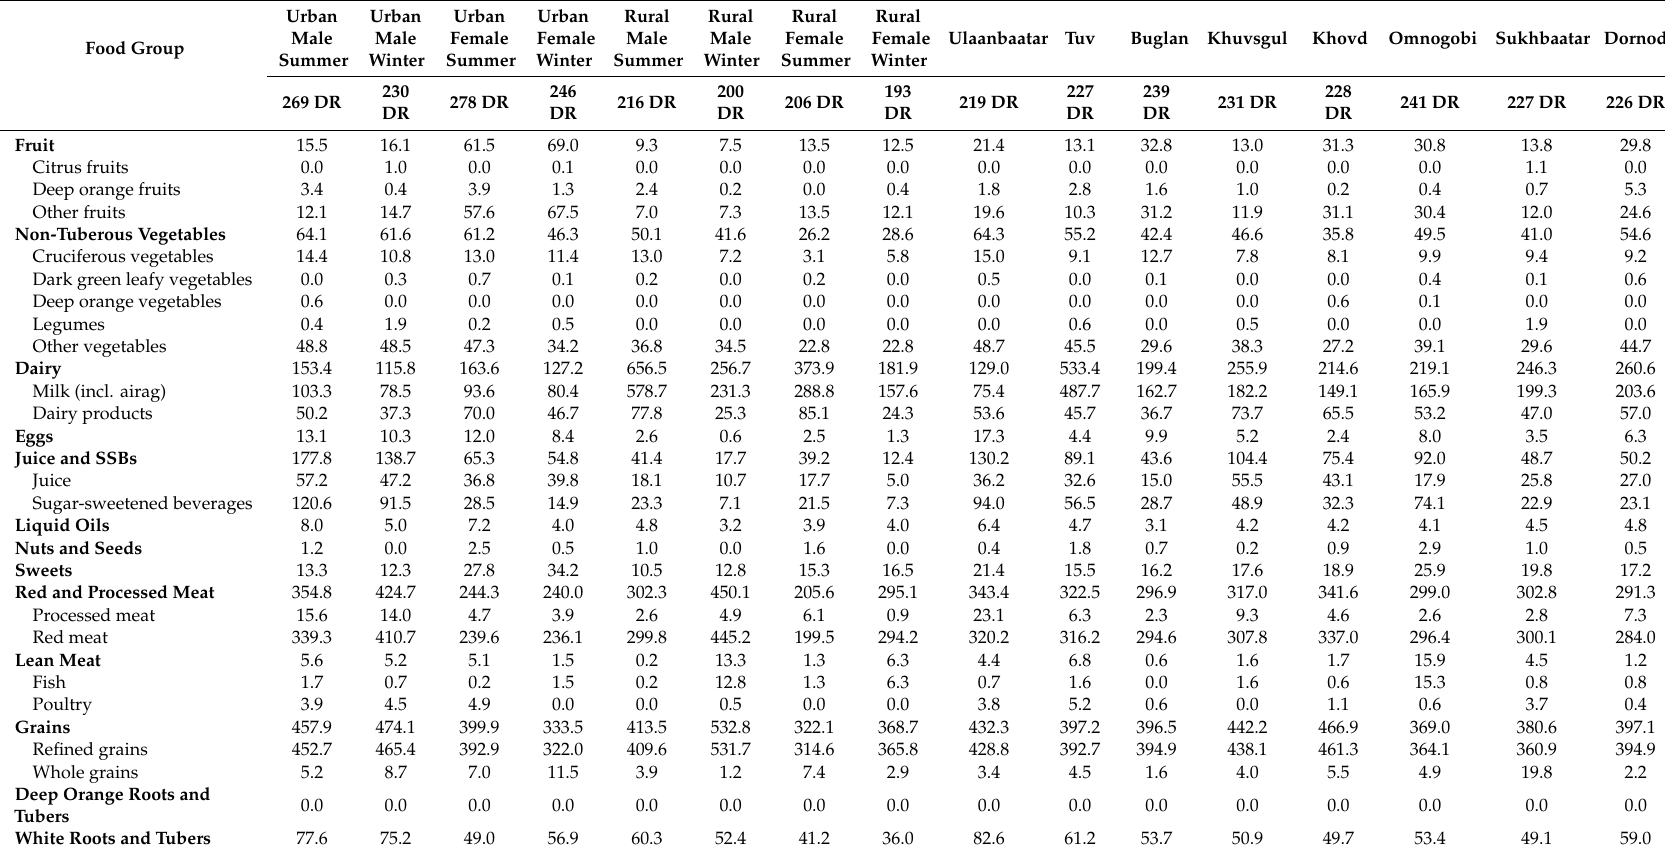
Table 1. Mean usual intake (g / day) and intake density (g / 2500 kcal / day) of food groups by subgroup-season and